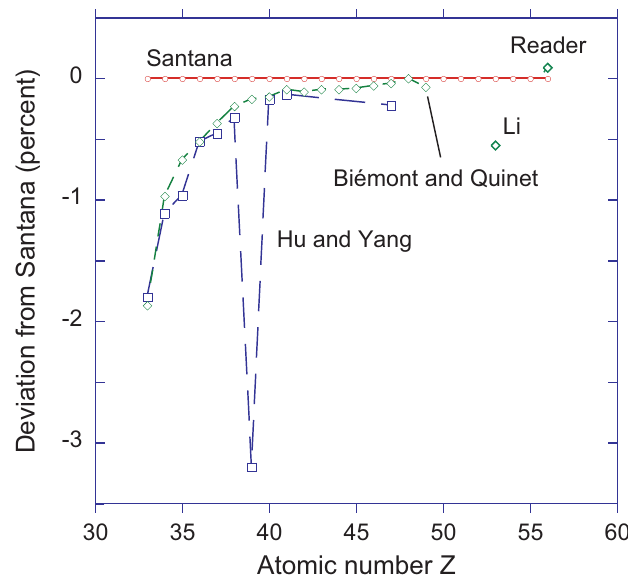
Figure 7. Deviation of the 4s 2 4p 2 P o ground state fine structure in Ga-like ions from the MRMP computational results obtained by Santana [13] (open circles at zero line). The Biémont and Quinet [69] data have been semi-empirically adjusted to the low- Z experimental data. Evidently, the multi-configuration Dirac–Fock (MCDF) calculations by Hu and Yang [96] are close to the isoelectronic trend of the experimental data, but for Z = 39, they deviate markedly, which jeopardizes their reliability. Li [57] MCDF result; Reader [98] experimental data